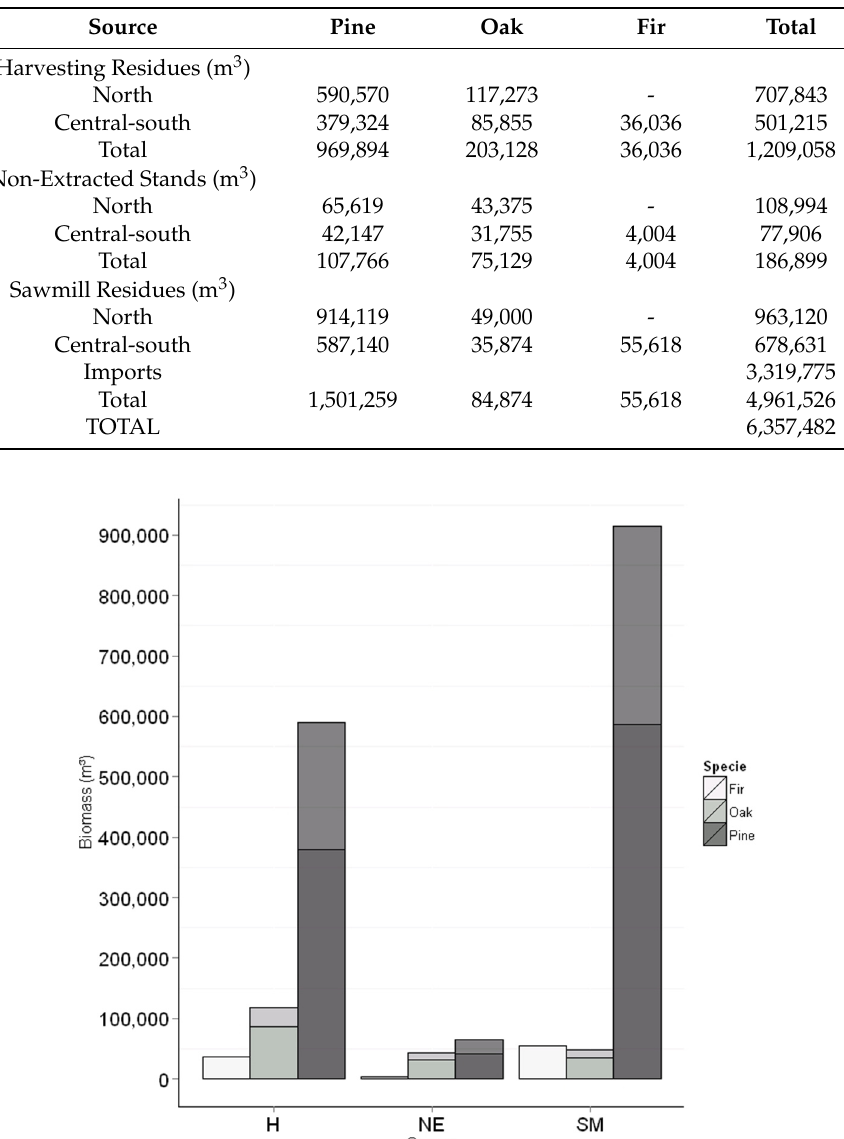
Figure 2. Theoretical availability of nationally produced woody biomass by source, species and region.